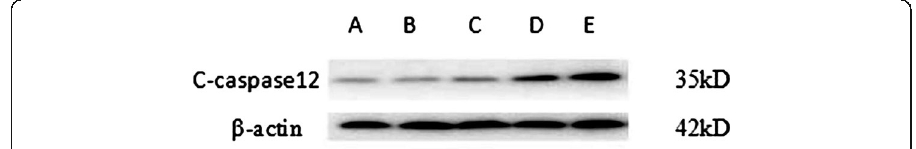
Fig. 5 C-caspase-12 protein expression in the different HSC groups as measured using western blot. A – blank group; B – TGF- β 1 group; C, D and E – TGF- β 1 + low, middle and and high dose of